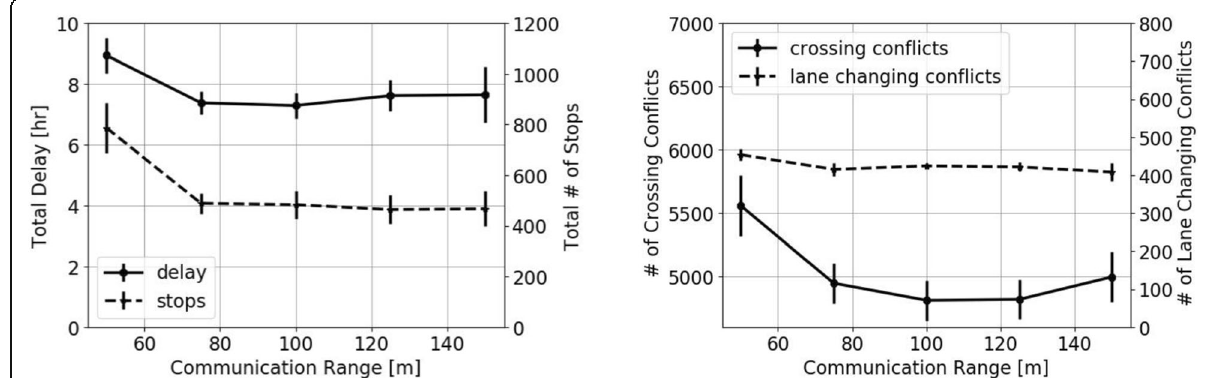
Fig. 7 Impact of communication range on delays, stops and